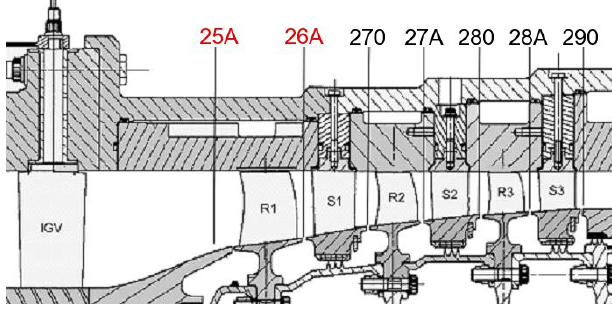
Figure 1. CREATE compressor meridian view. Table 1. Blade number for the